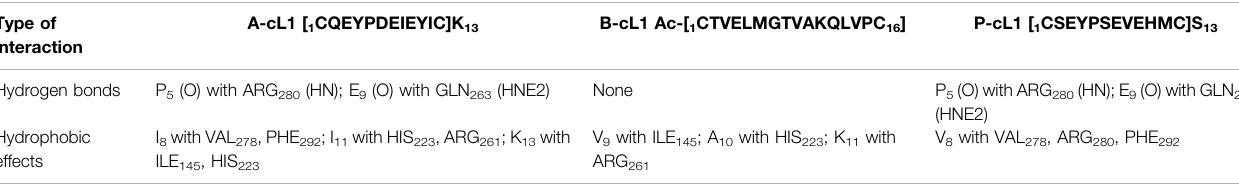
TABLE 2 | The interaction analysis of peptide A-cL1, B-cL1, and P-cL1 with VEGFR1 according to the docking. Type of